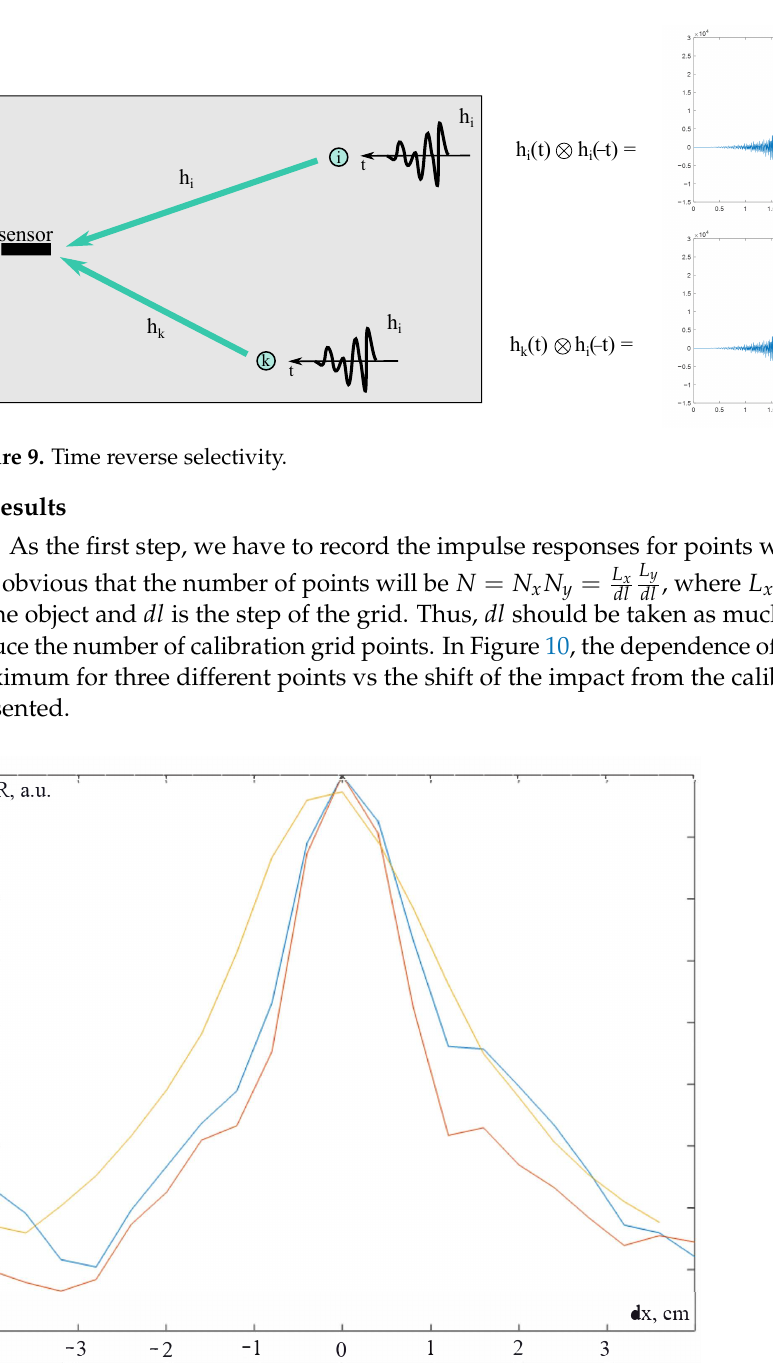
Figure 10. Dependence of the correlation maximum for 3 different points (different colors refer to different points) vs shift of the impact from the calibration